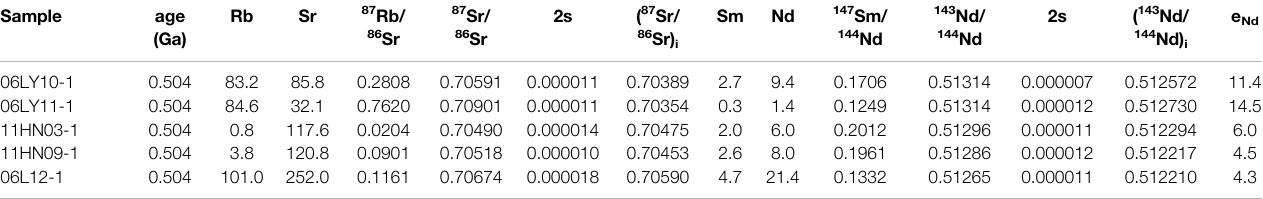
TABLE 4 | Sr-Nd isotopic data of basalt from the Huaniushan complex in the Beishan orogen, NW China.